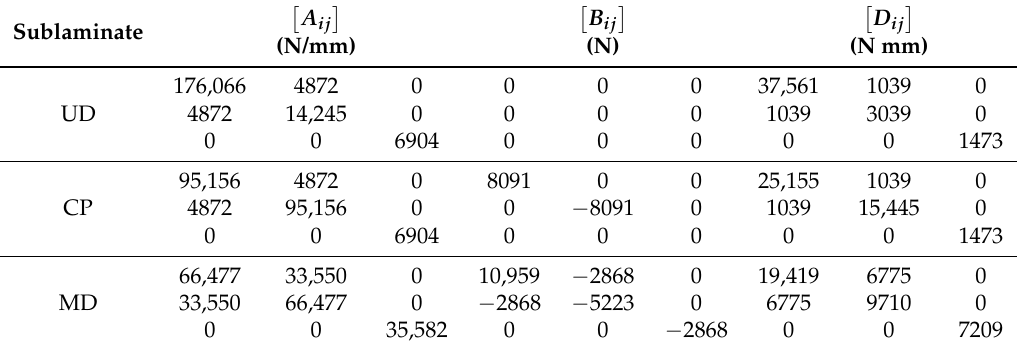
Table 3. Sublaminate plate stiffnesses.